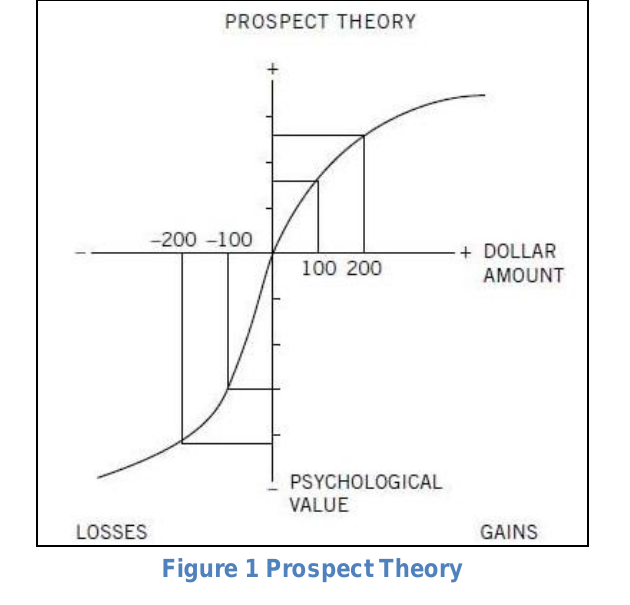
Figure 1 Prospect